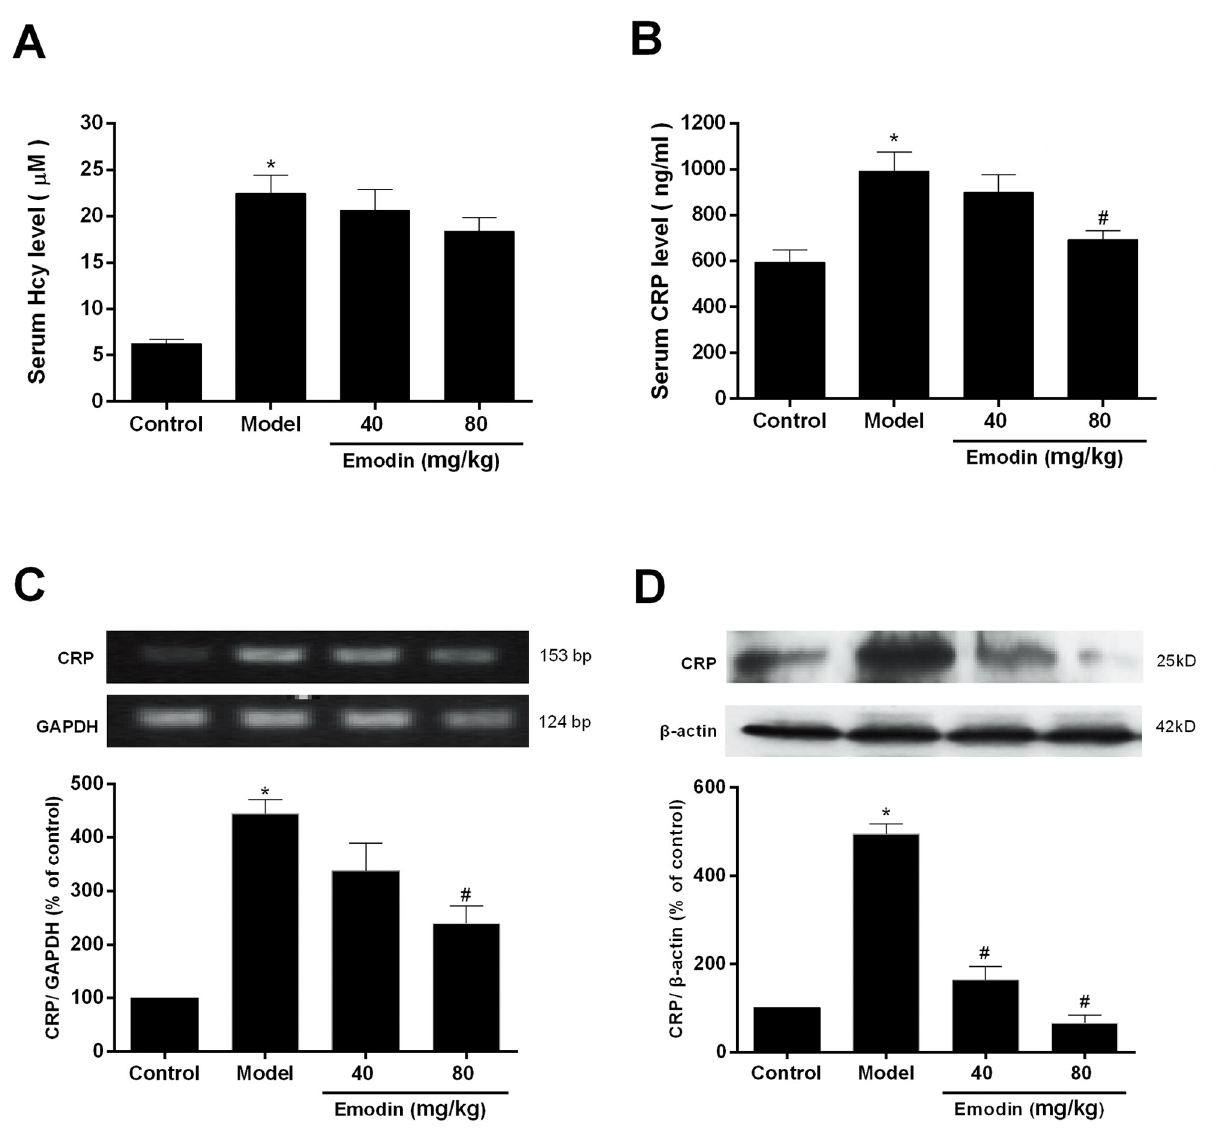
Fig 4. Effects of emodin on the serum Hcy and CRP levels and CRP expression in the thoracic aorta in hyperhomocysteinemic rats. Rats were fed with the high methionine diet for 4 weeks, and simultaneously treated with two doses of emodin. In the end of the experiment, the blood was collected for detecting serum Hcy level (A) with the enzyme cycling method and CRP concentration (B) with ELISA. Then, the thoracic aorta was removed for examining mRNA (C) and protein (D) expression of CRP by RT-PCR and Western blot, respectively. Data were expressed as mean ± S.E.M. (n = 8). * P < 0.05 vs . control, # P < 0.05 vs . model